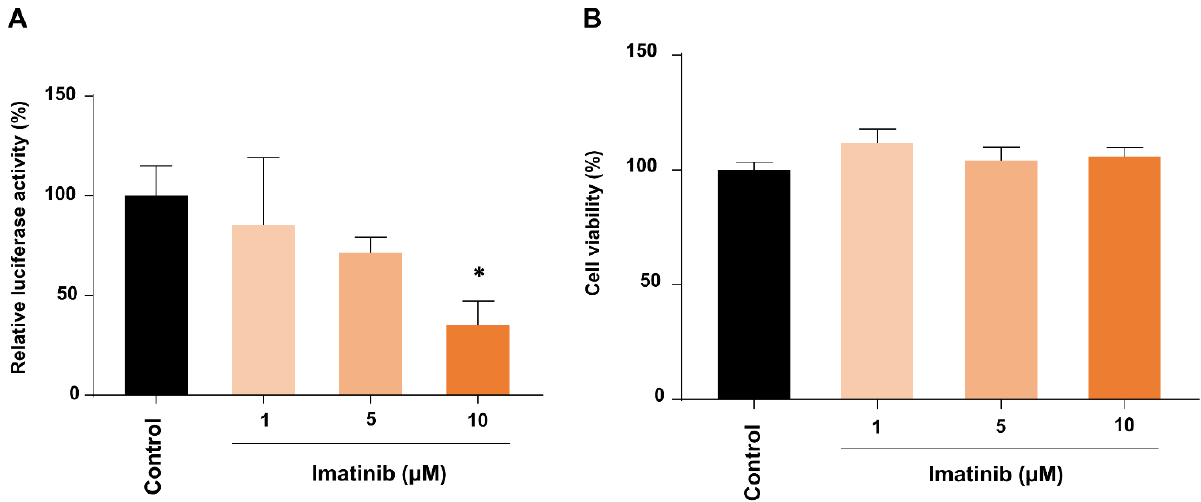
Figure 4. Imatinib inhibited the cell entry of SARS-CoV-2 pseudotype particles. ( A ) Vero E6 cells were pre-incubated with the indicated doses of imatinib for 24 h and then inoculated with the pseudotyped viral particles of SARS-CoV2-S virus; the viral entry was assessed by measuring the virus-encoded luciferase activity in cell lysates. The relative entry efficiency was quantitated by normalization with the efficiency of the untreated cells. Bars, standard deviation; * p < 0.05 determined by Student’s t -test. For each treatment, three biological repeats with quadruplicate samples were conducted. ( B ) Cell viability was measured using the Cell Titer Glo assay (Promega). Bars, standard deviation.